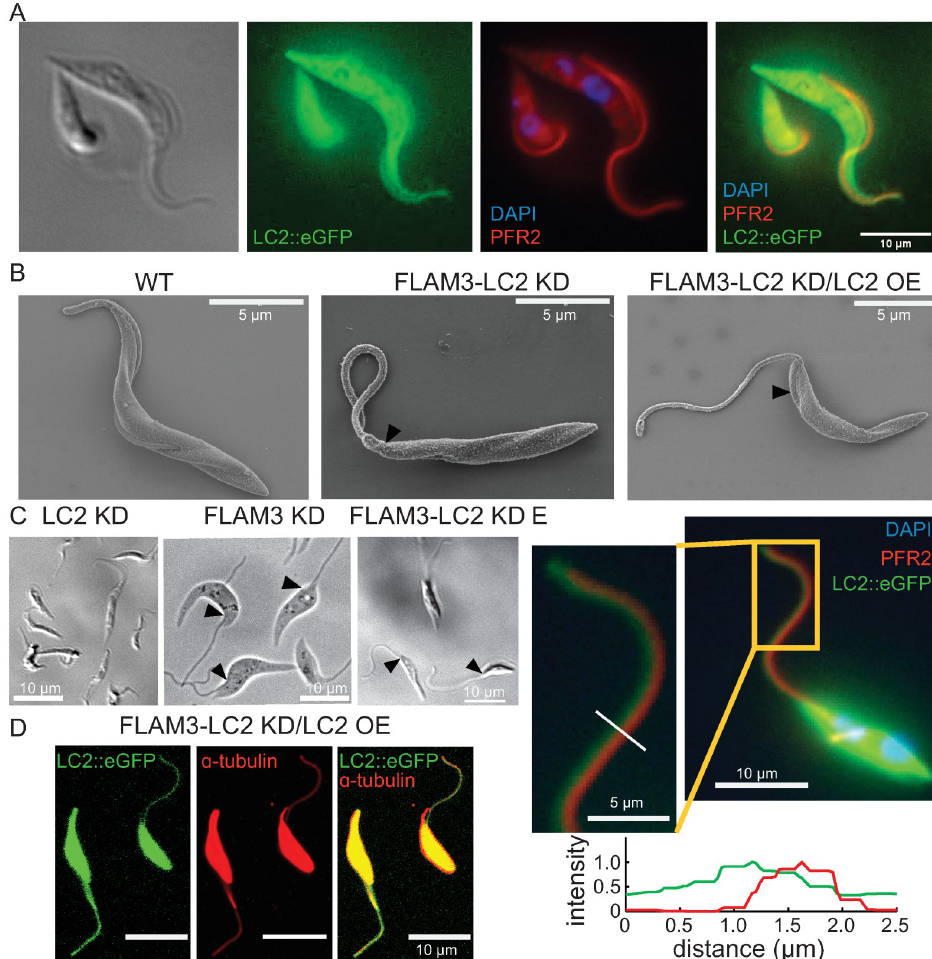
Fig 2. Overexpressed TbLC2 localized to the axoneme as well as the cytoplasm. A . Doxycycline induced TbLC2:: eGFP overexpressing wild-type cells (WT/LC2 OE cell) visualized using differential interference contrast (DIC) microscopy ( left ) and under widefield fluorescence microscopy ( right ). The TbLC2::eGFP ( green ) localized to the cytoplasm and the cilium. The immunostained paraflagellar rod 2 (PFR2, red ), DAPI stained DNA (DAPI, blue ), and TbLC2::eGFP overlay ( right ), suggest that the TbLC2 has ciliary and cytoplasmic localization. B . SEM images showing cilium and cell body morphology of wild-type (WT, left ), FLAM3-LC2 KD ( middle ), and FLAM3-LC2 KD/LC2 OE ( right ) cells showing short flagellar attachment zones ( arrows ) and nearly complete ciliary detachment from the cell body in the FLAM3 knocked down cells. The scale bar is 5 μ m in each panel. C . LC2 KD ( left ), FLAM3 KD ( center ), and FLAM3-LC2 KD ( right ) cells visualized with DIC microscopy showing short flagellar attachment zones ( arrows ) and nearly complete ciliary detachment from the cell body. D . TbLC2::eGFP ( green ) expressing FLAM3-LC2 KD/LC2 OE cells stained with anti- ɑ -tubulin antibody ( red ) visualized with a confocal microscope. E . TbLC2::eGFP ( green ) expressing FLAM3-LC2 KD/LC2 OE cells stained with DAPI ( blue ) and the anti-PFR2 antibody ( red ) visualized under a widefield fluorescence microscope. The inset shows that TbLC2::eGFP and the paraflagellar rod are separately localized, and the line scan plots shows the normalized fluorescence intensity of TbLC2::eGFP ( green ) and PFR2 ( red ) along the line ( white ) shown in the